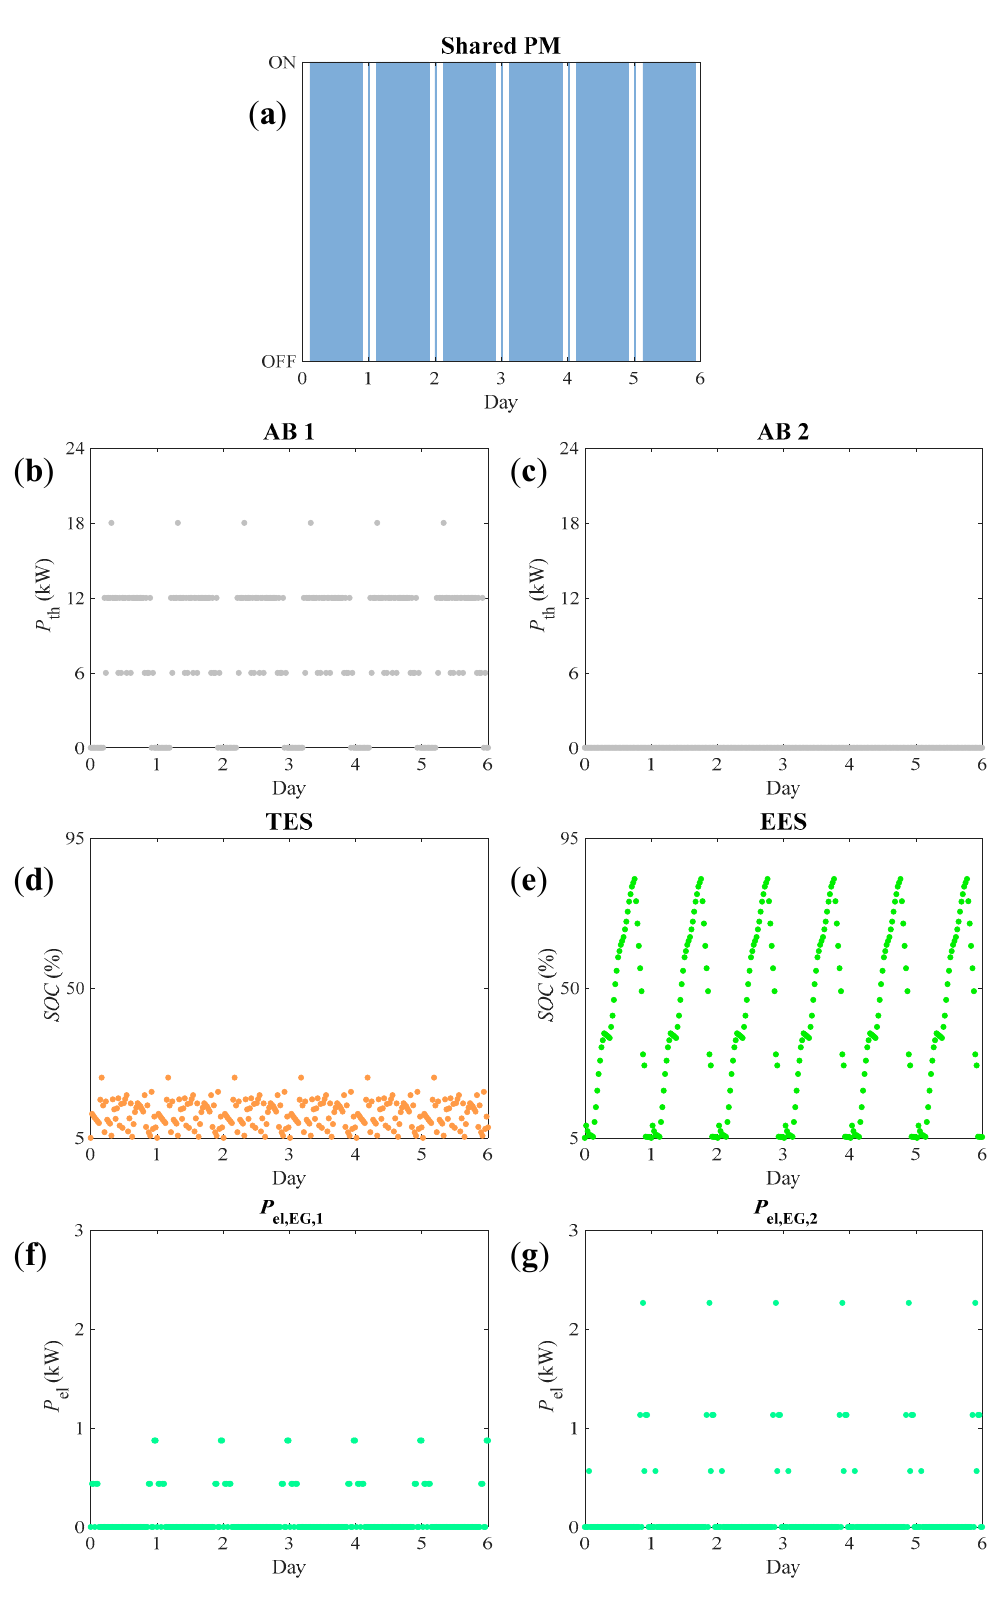
Figure 11. Best optimized strategy with “shared TES, EES and PM”: ( a ) shared PM switch-on time; ( b ) thermal power supplied by AB 1; ( c ) thermal power supplied by AB 2; ( d ) state of charge of the TES; ( e ) state of charge of the EES; ( f ) electric power taken from the electrical grid by user 1; ( g ) electric power taken from the electrical grid by user 2.